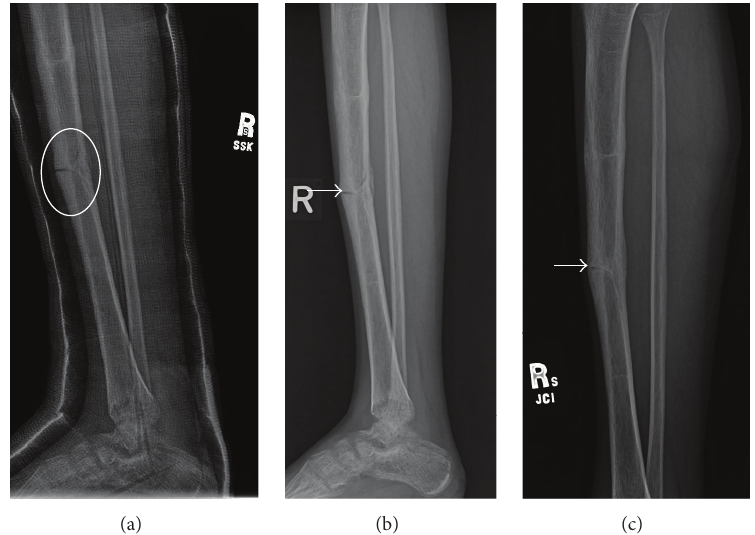
Figure 2: Young adult male with history of Rothmund-Thomson syndrome diagnosed at 2 years of age. Findings: (a) follow-up radiograph 5 months after injury shows delayed union of the tibia diaphyseal fracture with less than 50% bridging bone at the fracture (oval). (b) 7-month follow-upradiographshowsapproximately50%bridgingboneatthetibiadiaphysealfracturewithfracturelinestilleasilyvisualizedanteriorly (arrow). (c) Final follow-up radiograph obtained 13 months after initial injury shows near-complete bridging bone across the fracture with fracture line still faintly apparent anteriorly (arrow). Technique: (a) lateral radiograph kVp = 60, mAs = 4, (b) lateral radiograph kVp = 63, mAs = 3, and (c) lateral radiograph kVp = 60, mAs =